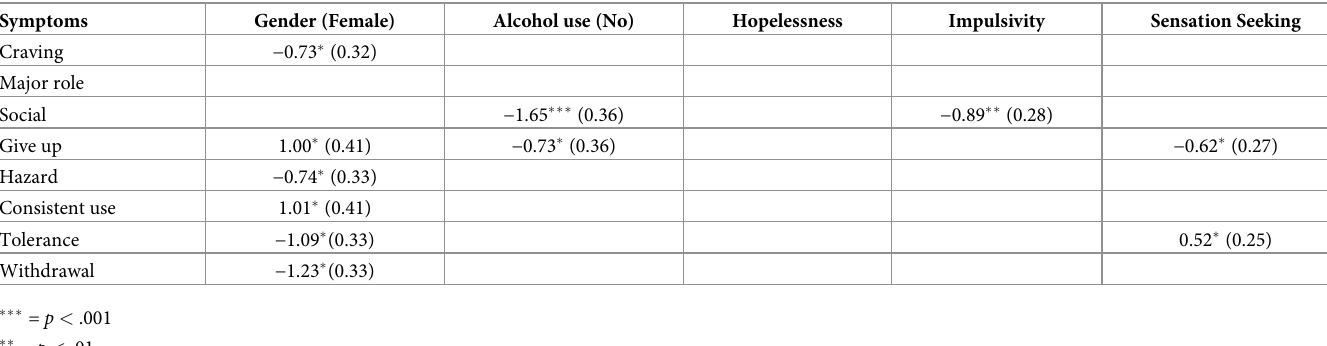
Table 5. Identified DIF items by each person predictor.